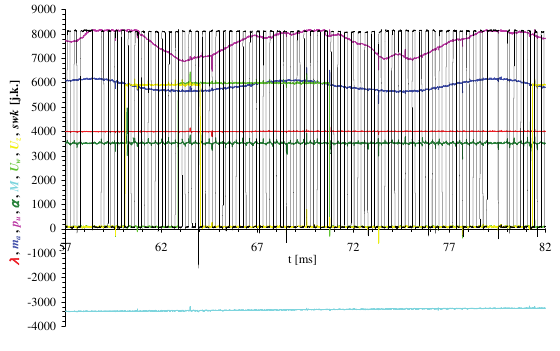
Fig. 7. Exemplary process of registered signals